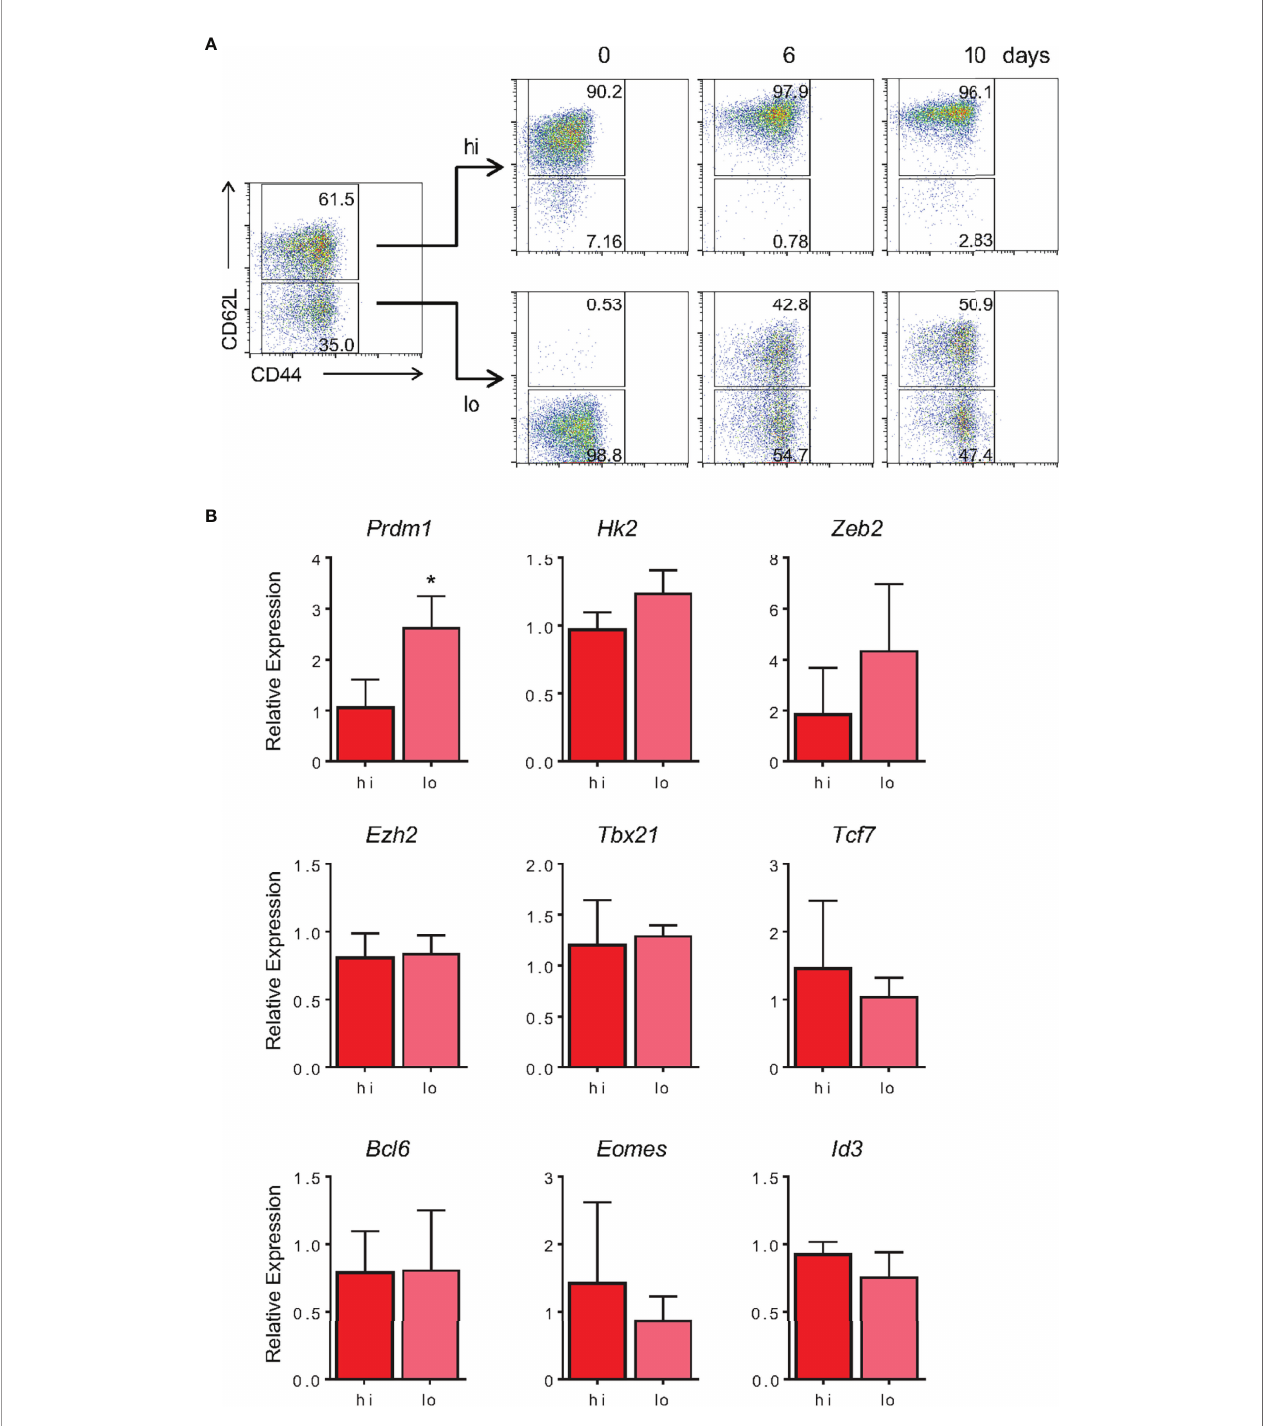
FIGURE 11 | In Vitro -Generated T EM-Like Are Able to Give Rise to T CM-Like Cells in Culture. (A) Memory CD8 T cells generated in vitro were sorted according to CD62L fl uorescently labeled monoclonal antibody staining at day 10 of culture. After sorting, CD62L lo and CD62L hi were cultured separately, maintaining the same cell concentration at day 10 of culture. The CD44 and CD62L markers were evaluated on the same day, 6 and 10 days after sorting. The results are representative of two independent experiments. (B) Expression of noted genes by sorted CD62L high or low memory cells after 10 days in vitro was quanti fi ed by real-time RT-PCR using TaqMan probes. Data were normalized to the Hprt housekeeping gene, and the reference was the lowest Ct mean obtained from the CD62L hi population. Bar graphs represent the mean ( ± SD) of the RNA expression analysis. The (*) indicates p < 0.05. The results are representative of three independent